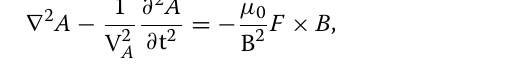
Fig. 7 Schematic diagram of a pair of the Earth-ionosphere waveguide for the positive electric potential (Φ potential (Φ - ) on the dawnside, supplied by the PI dynamo through the field-aligned currents in the magnetosphere. The electric potentials are transmitted from the polar